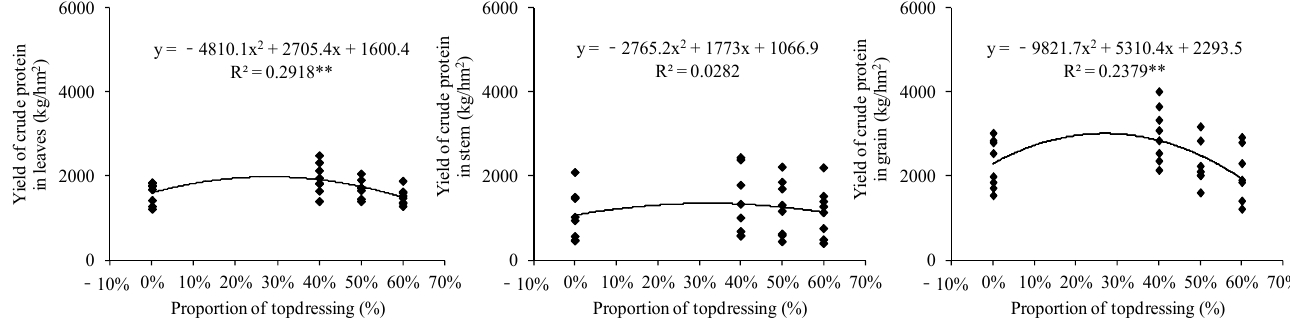
Figure 14. Relationship between crude protein yield and fertilization method for 60,000 plants per ha − 1 . Note: “**” indicate a significant correlation at the 0.01 probability level. The dots represent the measured values, and the lines represent the correlation trend in the figure.